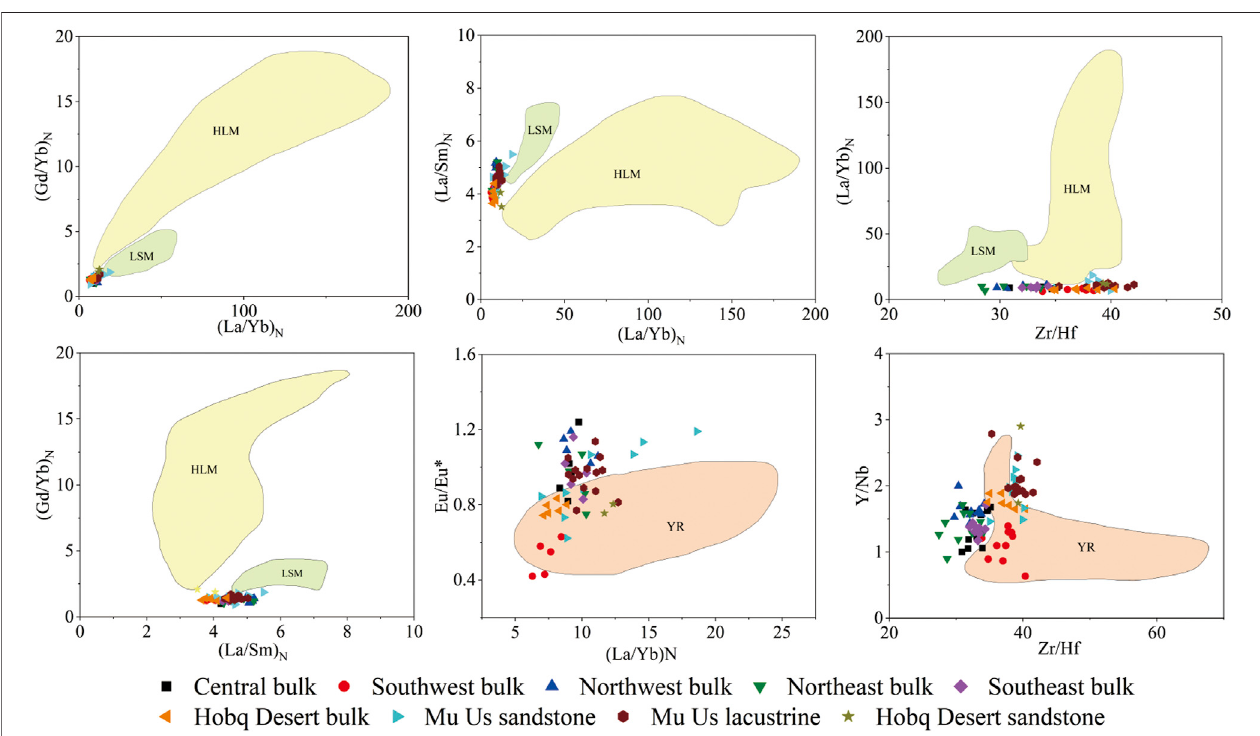
FIGURE12 | Bivariate diagrams ofgeochemical elements ratios ofsamplesbetweenthe Ordos Deserts and their potential source areas.Data from other potential areasincludingthosefromtheHelanMountains(Danetal.,2014;LiW.etal.,2017),theLangshanMountain(Wangetal.,2017;Wangetal.,2018),theYellowRiver(data from Rao et al., 2011b; Liu et al., 2013; Pang et al., 2018). Data of sandstone and lacustrine sediments in Mu Us and the Hobq Desert is from Liu and Yang (2018). Abbreviations: HLM, the Helan Mountains; LSM, the Langshan Mountain; YR, the Yellow